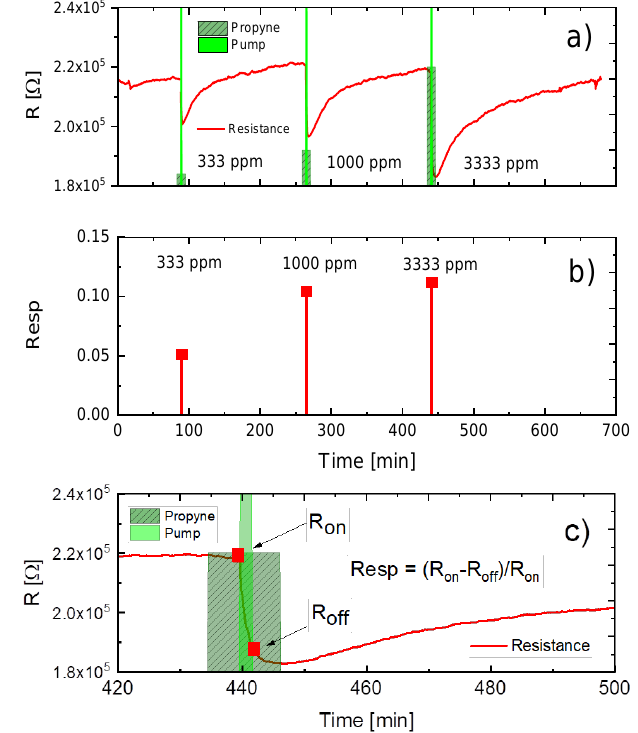
Figure 7. ( a ) Variation of MOX sensor resistance in response to three propyne sampling events; ( b ) relative resistance responses as evaluated from the sampling-induced MOX resistance changes in ( a ); ( c ) determination of the relative resistance response from the sensor resistance values observed upon pump-on and pump-off trigger events.